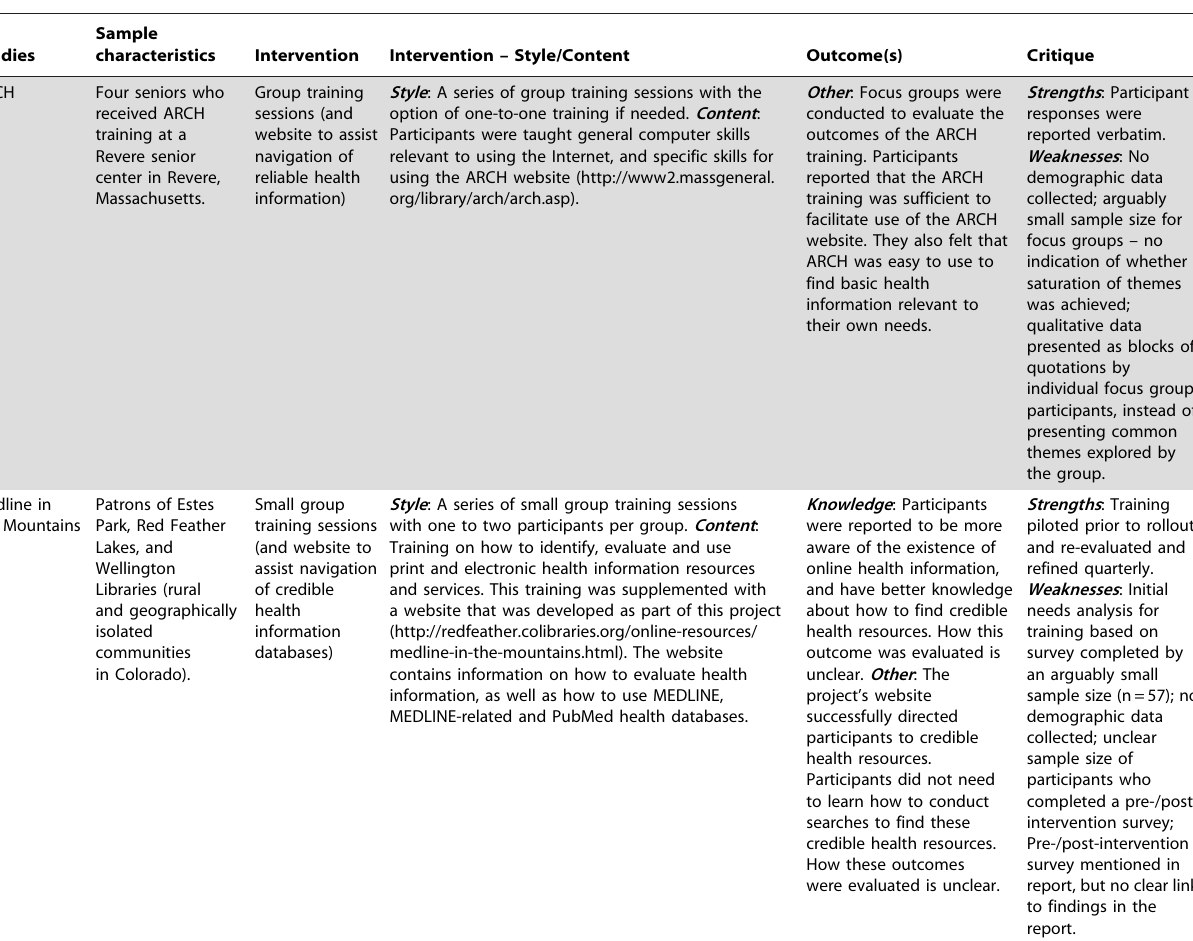
Table 2. Summary of Interventions, Outcomes, and Brief Critique – Gray Literature